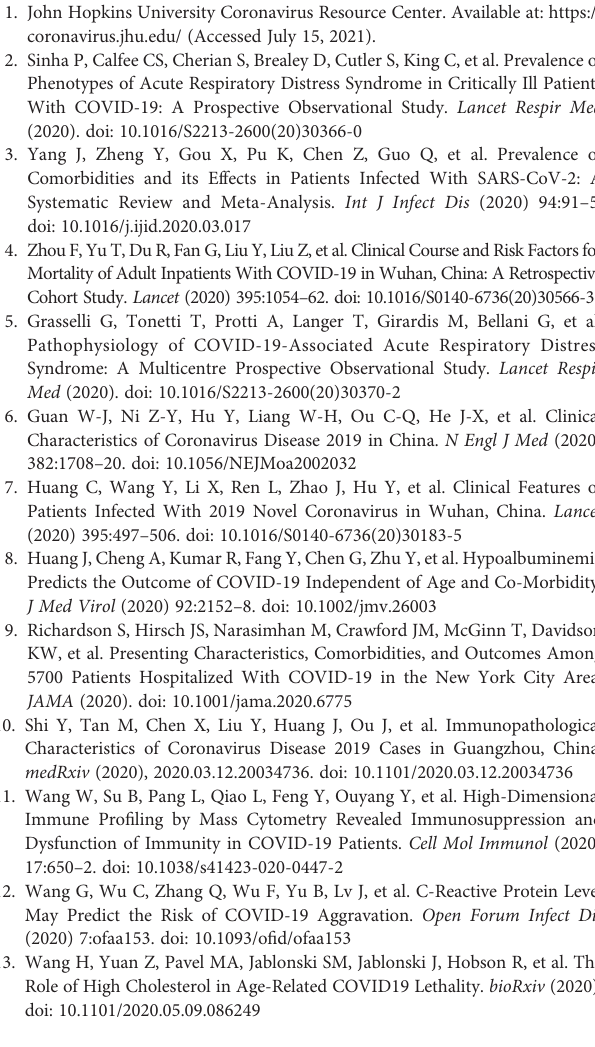
(F) Absolute abundance of metabolites depending on their density or size. (G) Measures of reproducibility and signal-to-noise for all metabolites in the panel. (H) Relationship between mean and variance for all variables in the panel. (I) Pair-wise correlation of metabolite abundance. Supplementary Figure 2 | Metabolic changes associated with COVID-19 severity. (A) Number of signi fi cant (p < 0.05 FDR) variables for a joint model of COVID-19 severity, patient age, BMI, and race. (B) Volcano plot of changes in metabolites associated with COVID-19 severity. (C) Heatmap of relative metabolite abundance for all samples where the axes have been sorted by the amount of change. (D) Abundance of metabolites with signi fi cant association with COVID-19 severity depending on WHO score. Supplementary Figure 3 | Metabolic and clinical association of disease severity. (A) Distribution of log fold-changes in lipoprotein particle metabolites depending on their size (upper row) or density (lower row). The coef fi cients represent the change associated with hospitalization, death and disease severity. (B) Volcano plot of clinical variables associated with COVID-19 severity in our cohort. (C) Distribution of clinical parameters in the samples dependent of COVID-19 severity. The horizontal grey areas represent a healthy range for each parameter.